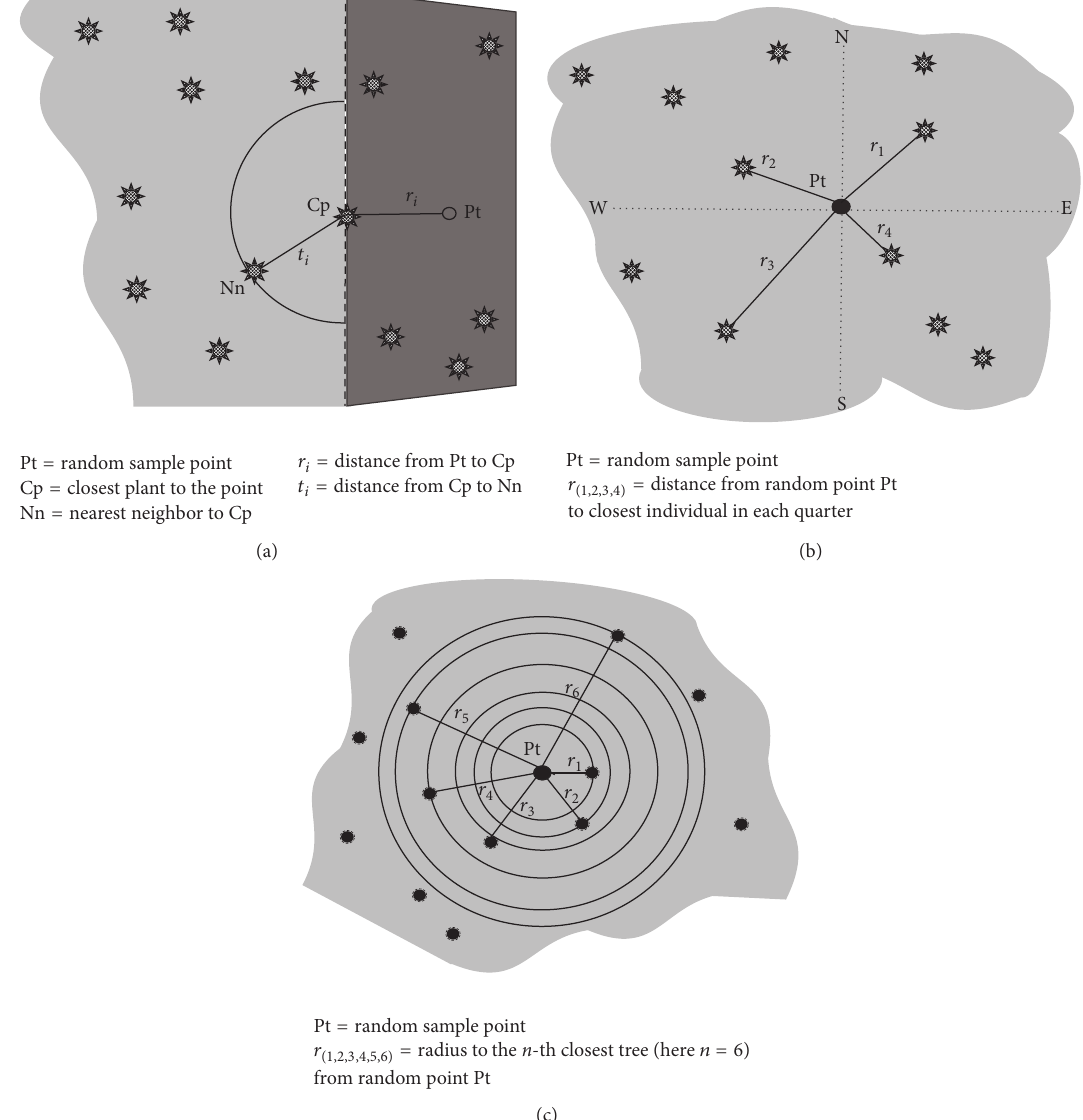
Figure 2: Application of 𝑇 -Square sampling (a); Point Centered Quarter Method (b); and 𝑁 -tree sampling method